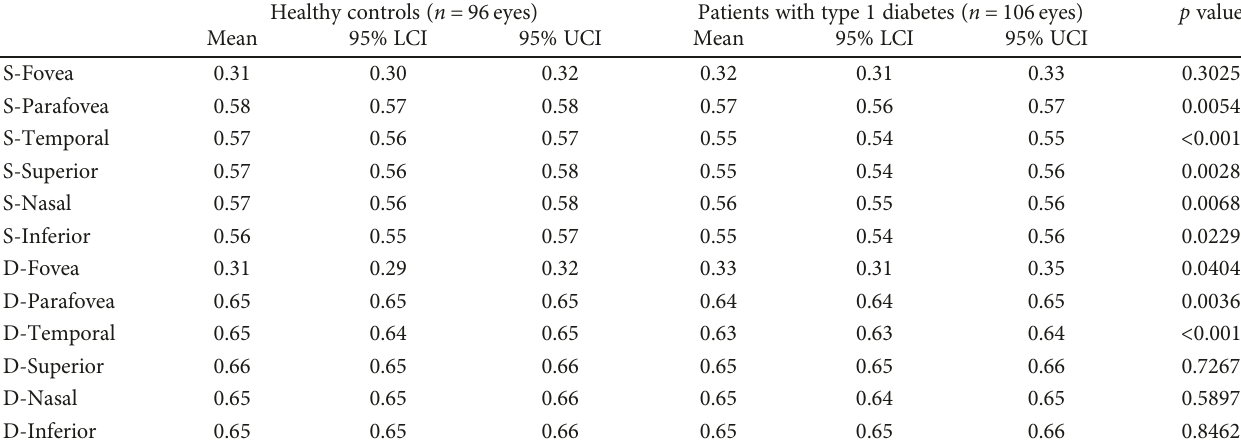
Table 2: Vascular densities of the super fi cial and deep plexus in patients with type 1 diabetes and healthy controls. Healthy controls ( n = 96 eyes ) Patients with type 1 diabetes ( n = 106 eyes